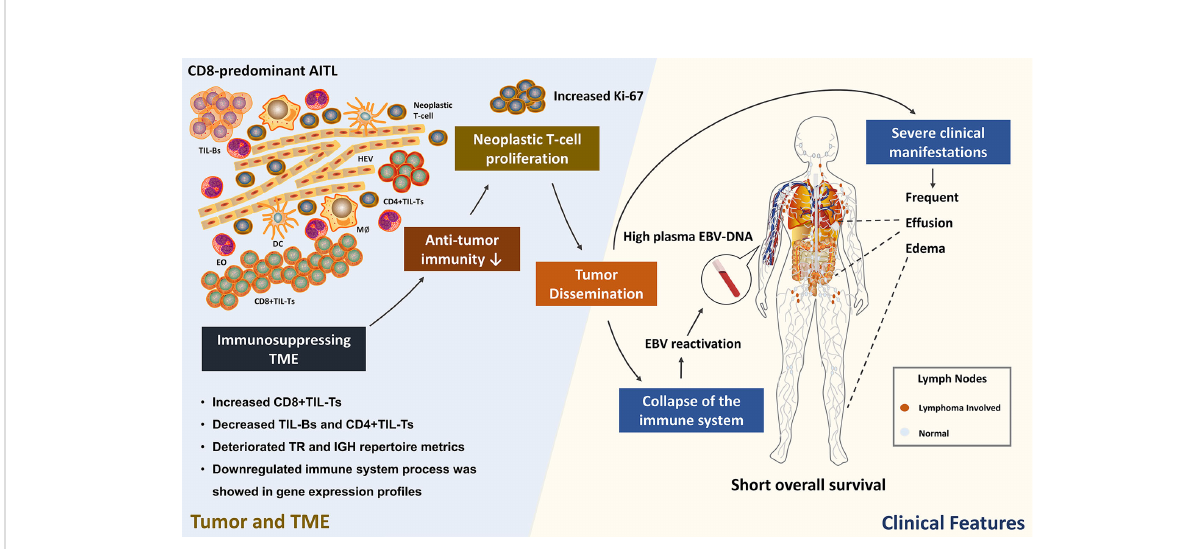
FIGURE 6 Hypothesized correlation between CD8-predominant AITL TME immune function and clinicopathological features. TIL, tumor in fi ltrating lymphocyte; HEV, high endothelial venule; EO, eosinophil; DC, dendritic cell; M ∅ , macrophage. This fi gure was drawn using ScienceSlides 2016, VisiScience,